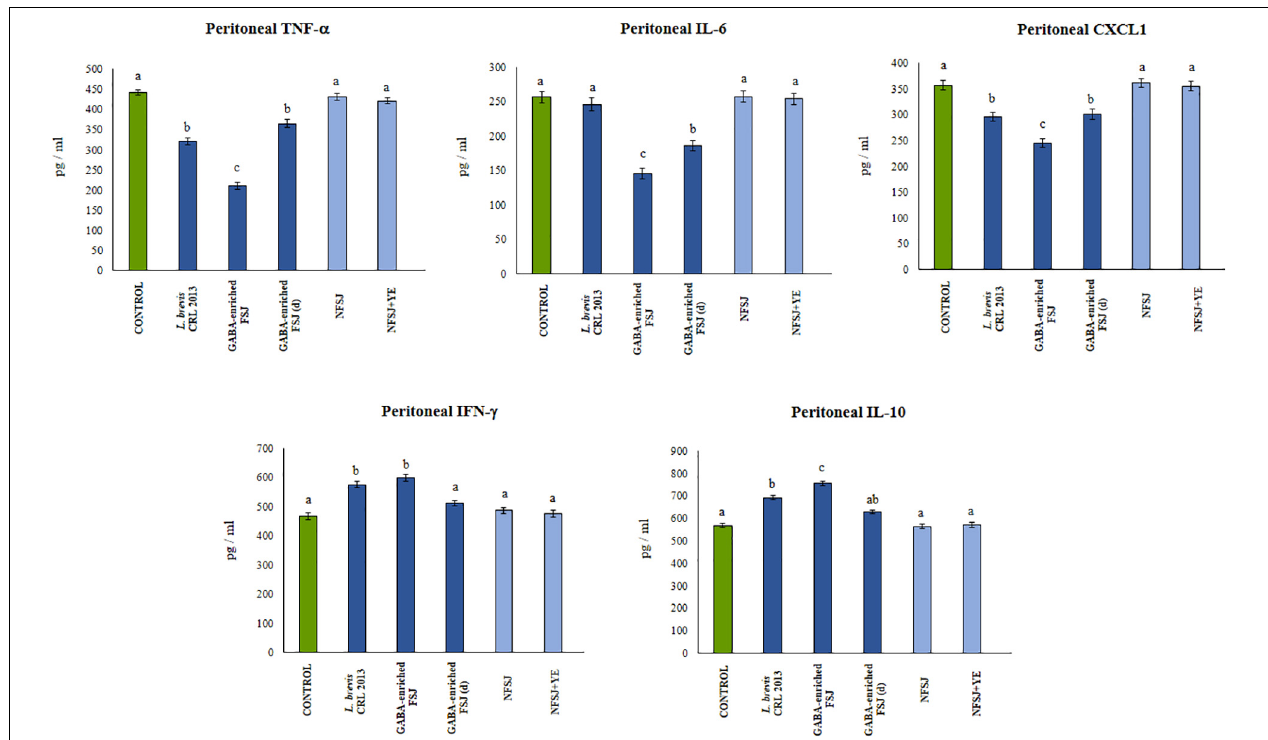
FIGURE 5 | Effect of L. brevis CRL 2013, GABA-enriched strawberry fermented juice (FSJ) and diluted (d) GABA-enriched FSJ on peritoneal cytokines and chemokines in mice challenged with LPS. Animals treated with NFSJ or NFSJ supplemented with YE were used for comparisons. Results are expressed as mean ± SD. Means for each bar without a common letter differ significantly. Significance with Tukey’s HSD post hoc test following a one-way ANOVA is indicated as p <